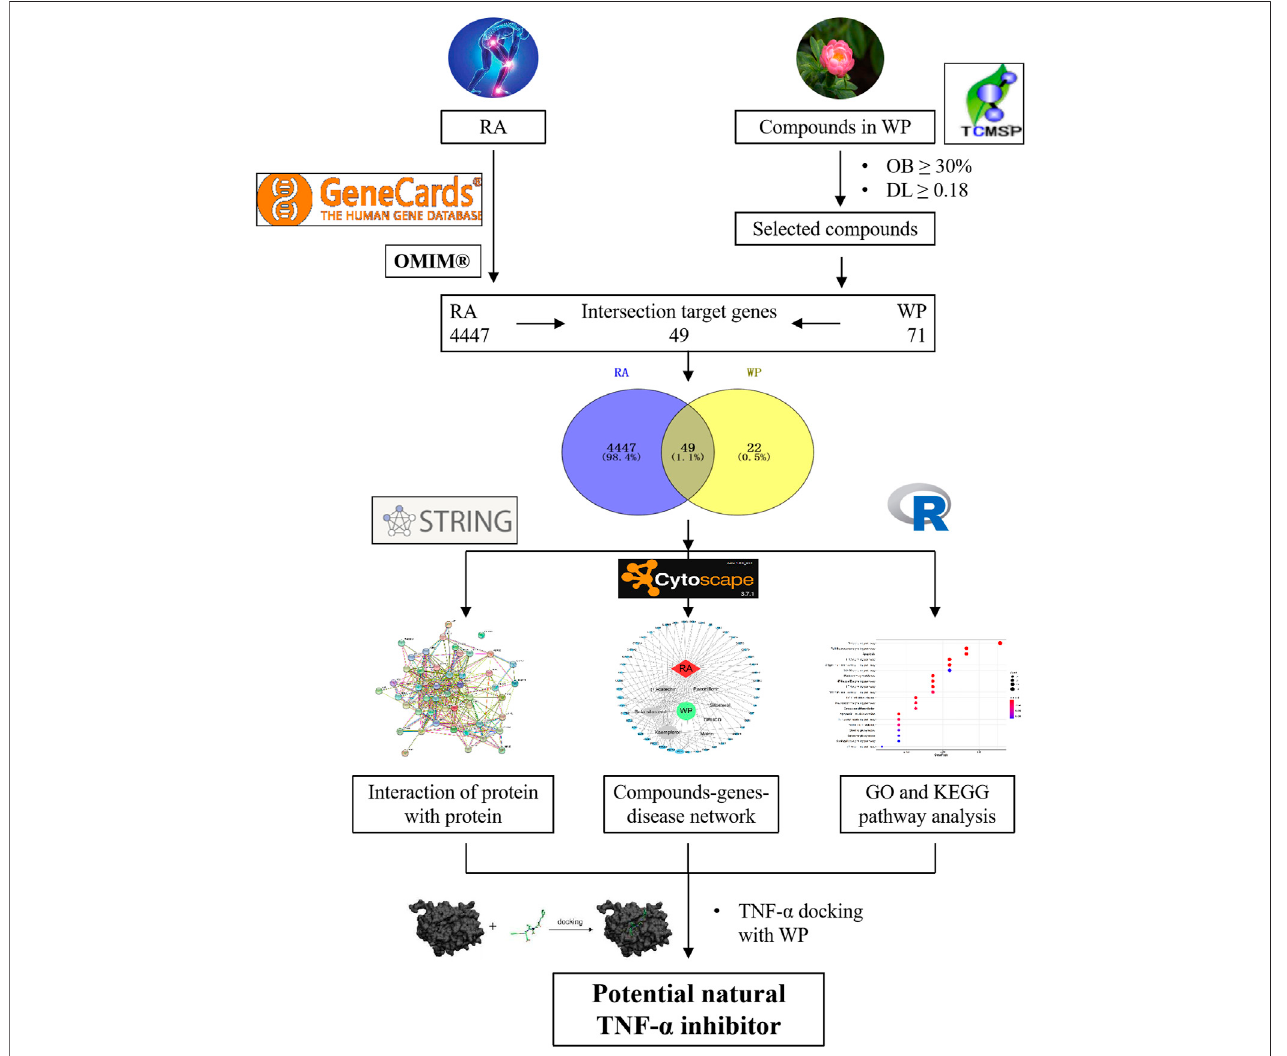
FIGURE 1 | The work fl ow of TNF- α inhibitor prediction in